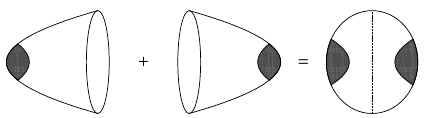
Figure 1 . Two copies (left) of conformally-compacti(cid:12)ed Schwarzschild-AdS d may be glued together to make a spacetime (right) describing a pair of black holes (right) on the Einstein Static Universe. Static slices are